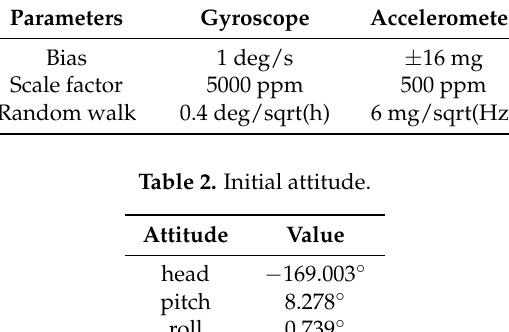
Figure 4. Hardware system configuration.